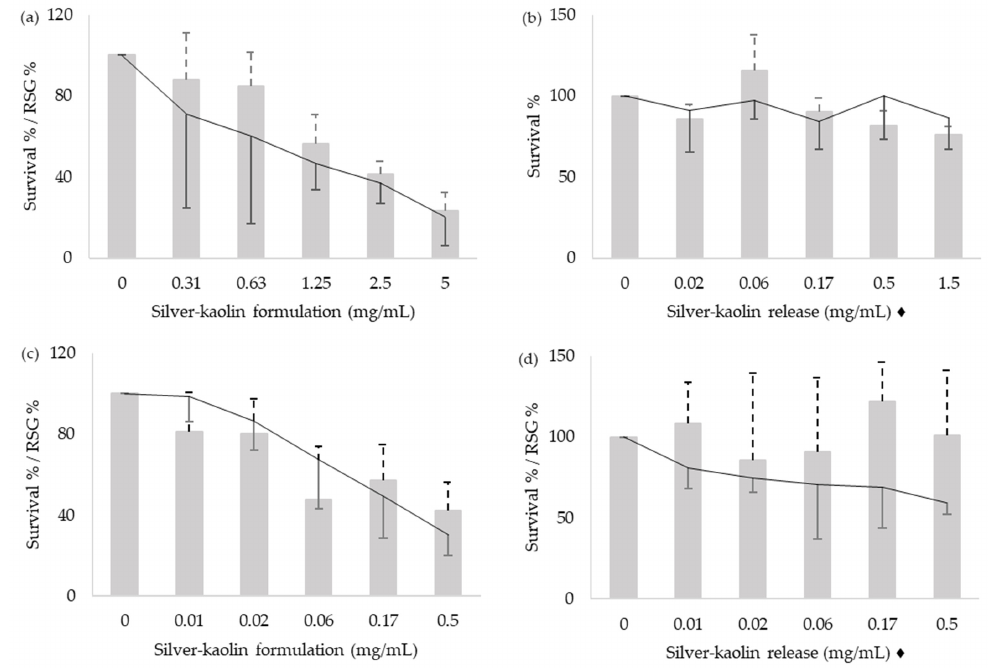
Figure 2. Results of the survival %, (bars with positive SD) and RSG % (lines with negative SD) of TK6 cells. Cells were treated with the silver-kaolin formulation for 3 h ( a ), silver-kaolin release for 3 h ( b ), silver-kaolin formulation for 24 h ( c ), and silver-kaolin release for 24 h ( d ). Means and SD of three independent experiments are represented. ♦ The concentrations indicated correspond to the silver-kaolin formulation that was in agitation for 24 h (see Section 2.3).